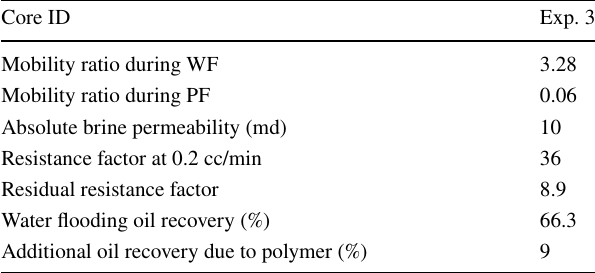
Fig. 16 Scanned image of Exp. 3 at S OR showing heterogeneity and vugs along the core. The red color in the image represents high CT number and hence high density Table 6 Summary of major results from third core flooding